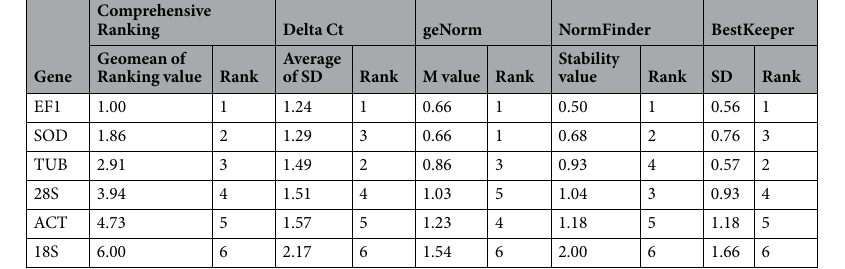
Table 2. Stability of candidate reference genes under ascovirus-infected conditions in M. similis